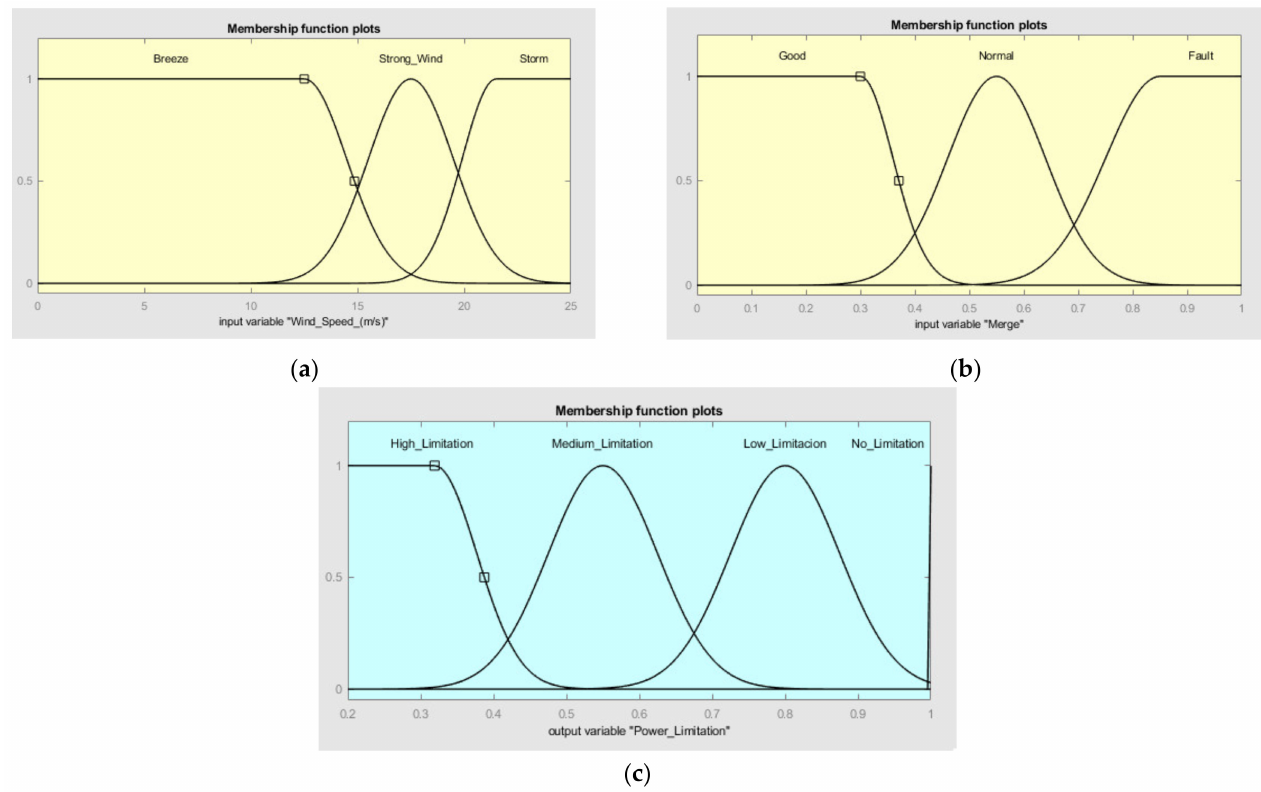
Figure 7. Input and output MF for the wind– merge controller: ( a ) wind speed MF; ( b ) merge indicator MF; ( c ) power limitation